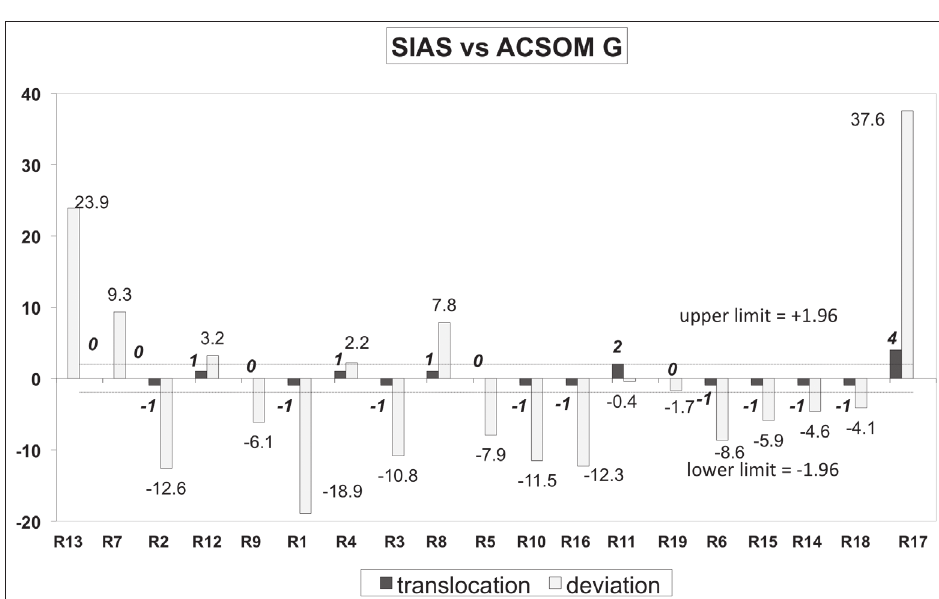
Figure 2 - SIAS vs ACSOM G Dual